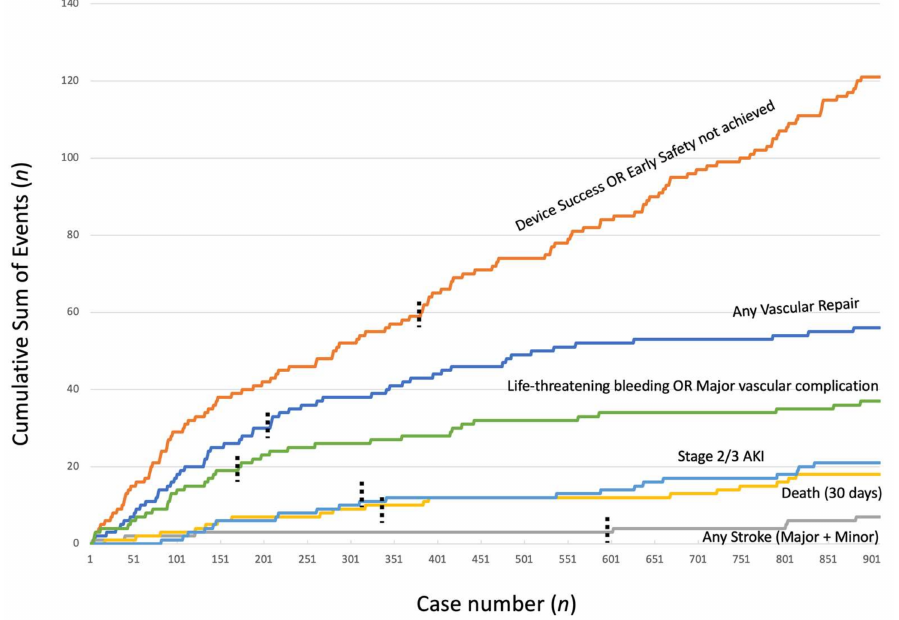
Figure 4. Individual endpoints analysis. Cumulative occurrence of the individual, more clinically relevant VARC-2 endpoints is provided. Vertical dashed bars represent the point at which 50% of each event had